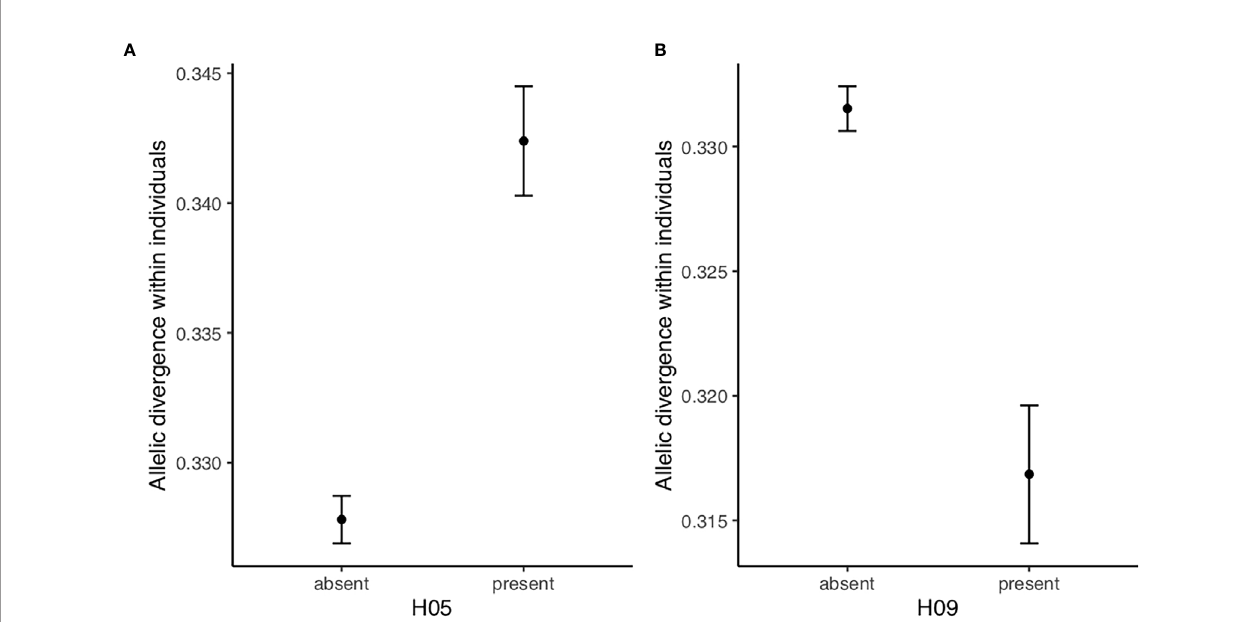
FIGURE 3 | Allelic divergence within individuals (LS means ± SE) for heterozygous bank voles is higher in bank voles with the resistance haplotype H05 and lower in bank voles with the susceptibilioty haplotype H09 (A) with and without haplotype H05, (B) with and without haplotype